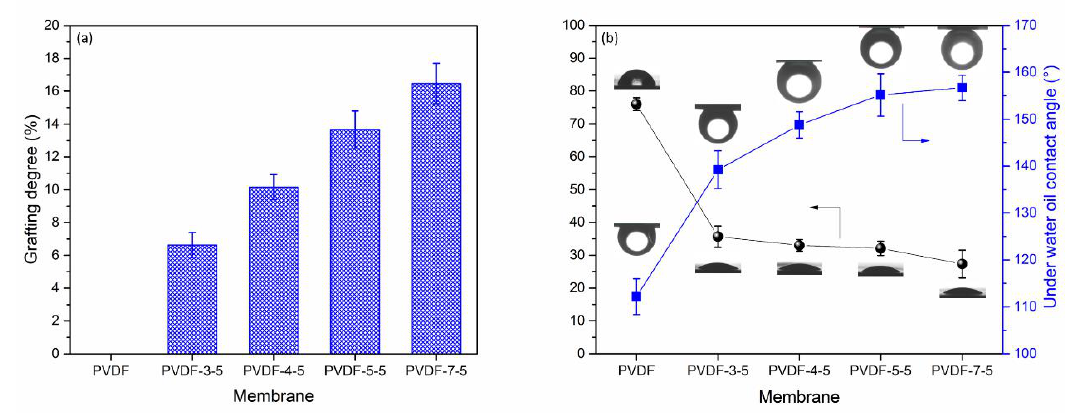
Figure 4. ( a ) Grafting degree, ( b ) water contact angle (black), and underwater oil contact angle (blue) of the resulting